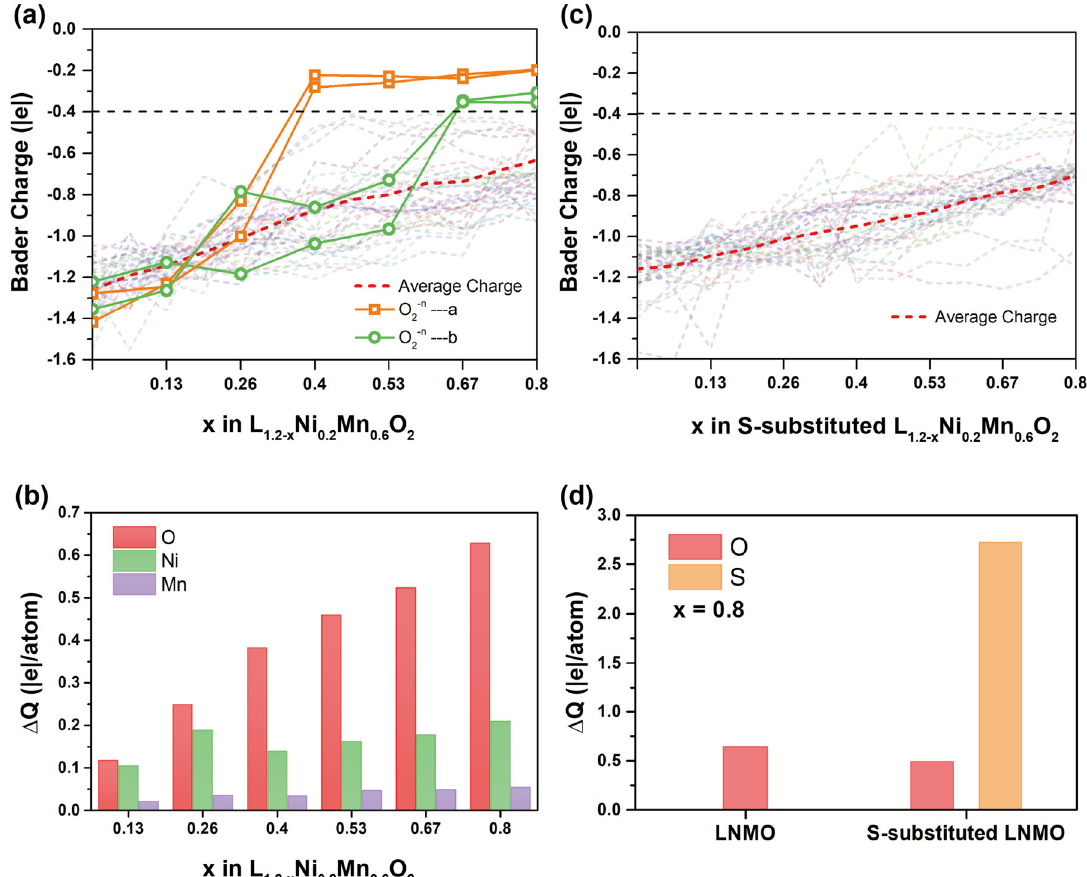
Fig. 3 Theoretical analysis of electronic properties. a Calculated Bader charge (|e|) of individual O atoms in the pristine LNMO (003) surface. The transparent line indicates the Bader charge of O n − anion, and all the value of Bader charge is blow than the black dashed line (a critical point of − 0.4). The orange and green line in a represents the Bader charge of O atoms in the O 2 molecule. The red dashed line indicates the average charge of O atoms in the system. b The change of atomic charge ( Δ Q in |e|/atom) of O, Ni, and Mn atoms in the pristine LNMO (003) surface at different levels of delithiation. c Calculated Bader charge (|e|) of individual O atoms in the S-substituted LNMO (003) surface. d An investigation into the Δ Q (|e|/atom) of O and S atoms in the pristine and S-substituted